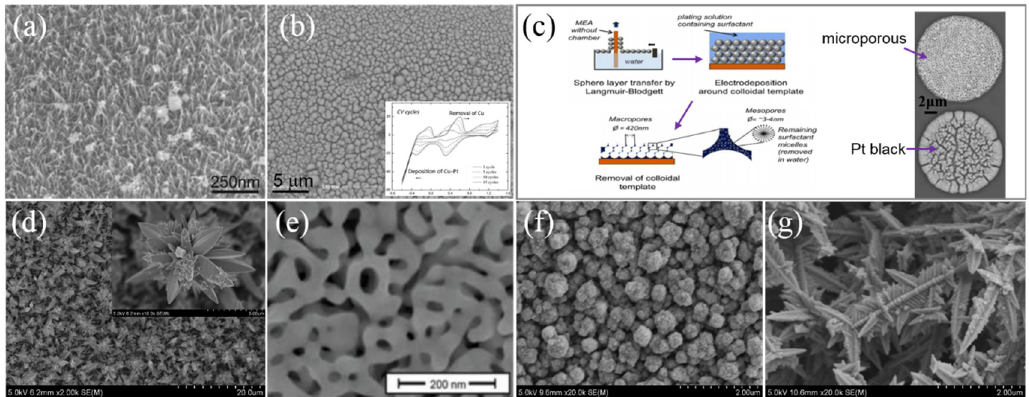
Figure 9. Scanning electron microscope (SEM) of different materials: ( a ) Pt-nanograss coating [80]; ( b ) cauliflower-like Pt coating [87]; ( c ) the fabrication process of depositing porous structure on electrode surface by templating [88]; ( d ) 3D nanocrystal Pt coating obtained by our group; ( e ) nanostructured Au coating by removing Ag from the Au–Ag alloy [96]; ( f ) IrO x / Pt nanocone composite coating in our group [94]; ( g ) IrO x / Pt nanoleaf composite coating in our group [95]. Reproduced from the mentioned references with permission from the related journals.